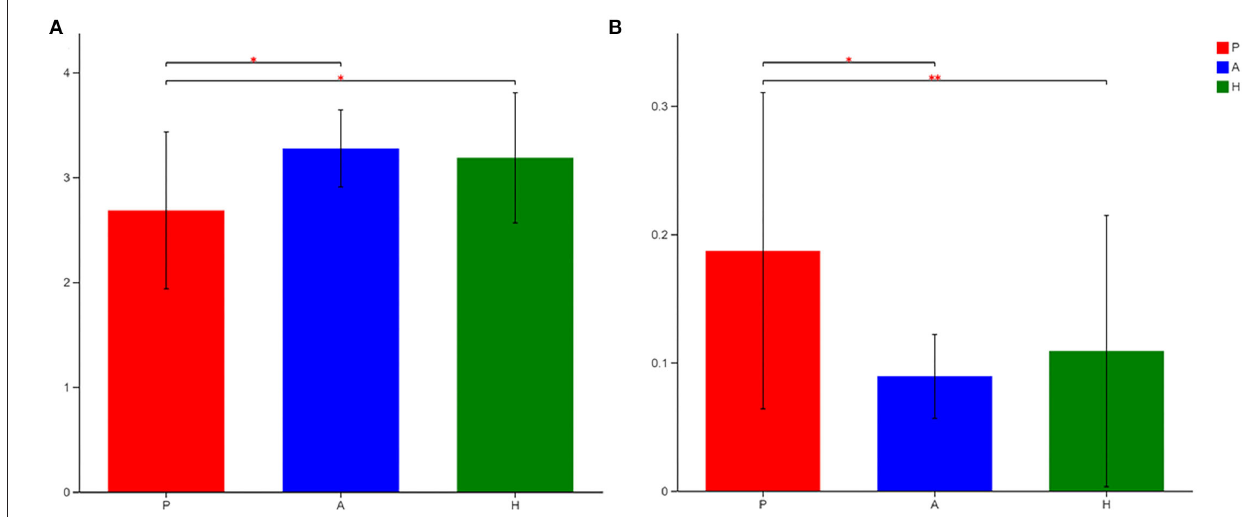
FIGURE 2 | Alpha-diversity of the gut bacteria in different groups at the OTU level. (A) Differences in the Shannon diversity index among Peutz–Jeghers syndrome (PJS) patients (group P), asymptomatic relatives (group A), and healthy controls (group H). The Shannon index described the diversity of the bacterial microbiota at the OTU level (Wilcoxon rank–sum test, * p < 0.05). The higher the Simpson index value, the higher the bacterial biodiversity. (B) The Simpson index described the diversity of the bacterial microbiota at the operational taxonomic unit (OTU) level (Wilcoxon rank–sum test, * p < 0.05; ** p < 0.01). The higher the Simpson index value, the lower the microbial